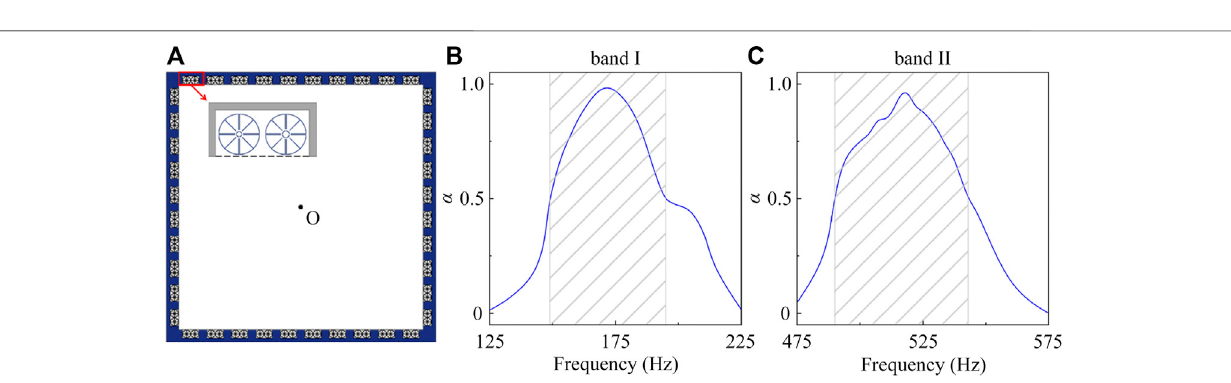
FIGURE4|(A) Schematicofabarrier-freeanechoicroomwithomnidirectionallow-frequencydual-bandsoundabsorption.Acylindricalsoundsourceislocatedat the point O. Simulated absorption spectra created by the barrier-free anechoic room around the bands (B) I and (C) II. The absorption coef fi cients are larger than 0.5 in the black shaded